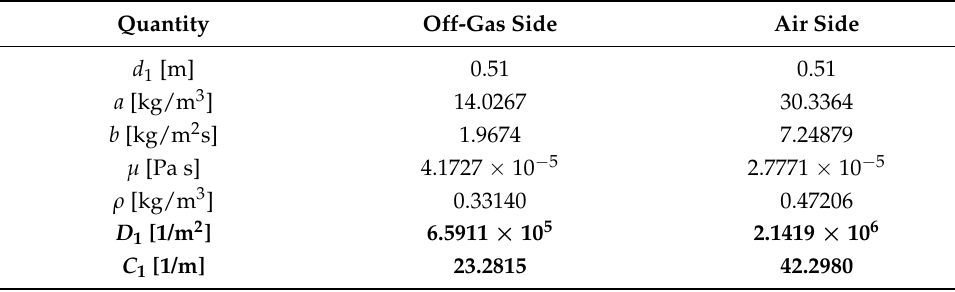
Table 4. Parameters for the calculation of pressure loss parameters.